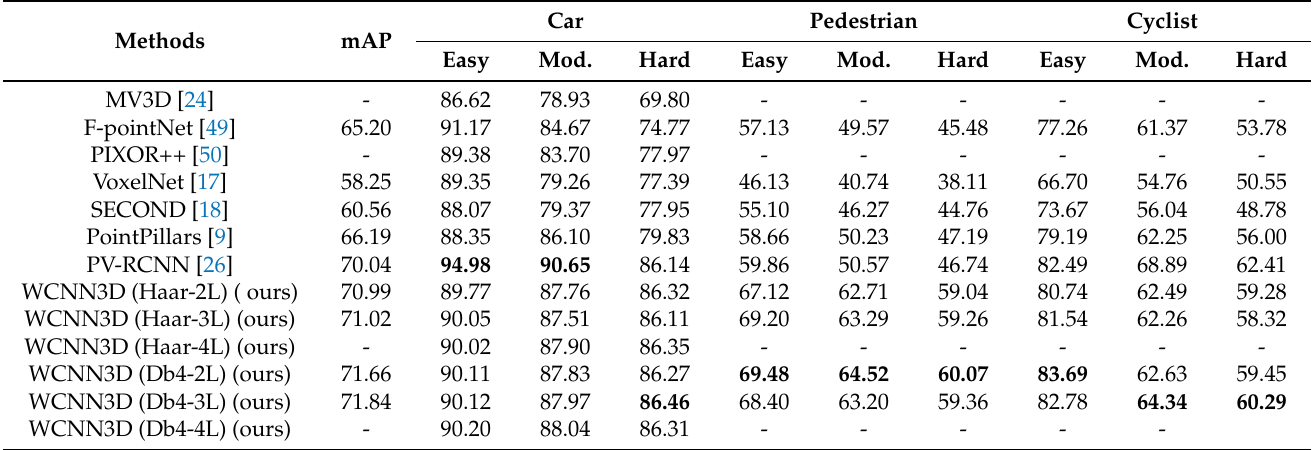
Table 1. 3D object detection result for Haar wavelet and Daubechies (Db4) on the KITTI test BEV